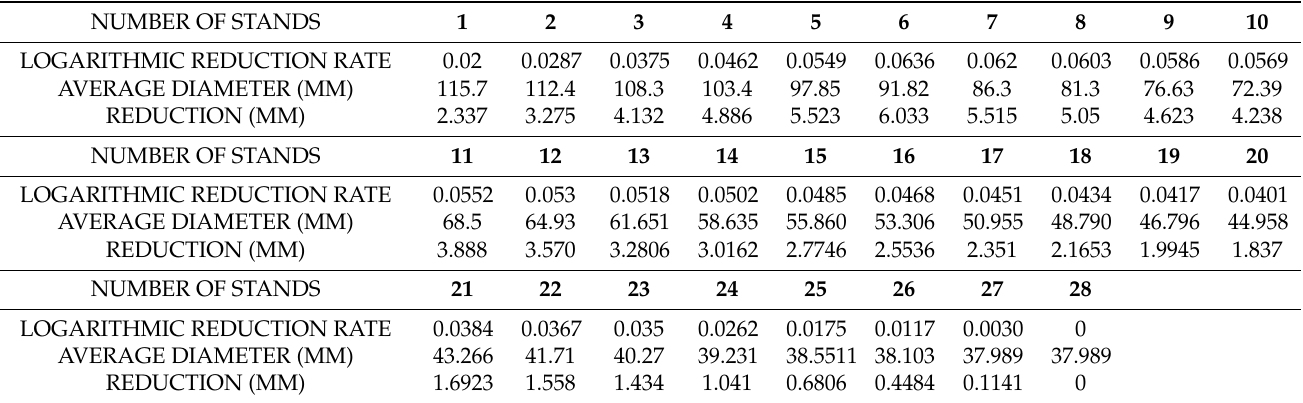
Table 1. Distribution of the reducing rate and reduction of 28 stretch-reducing mill sets.